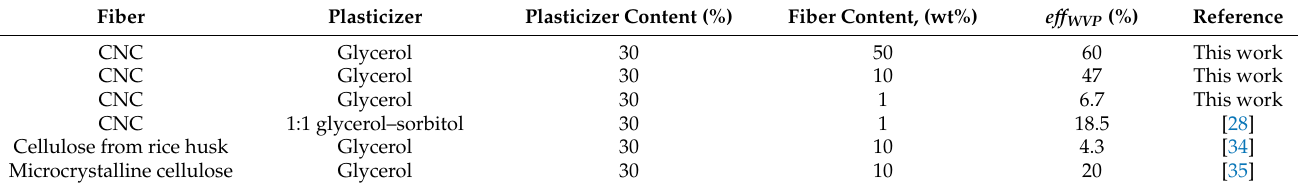
Table 1. Comparison of water vapor barrier improvement in TPS–cellulose